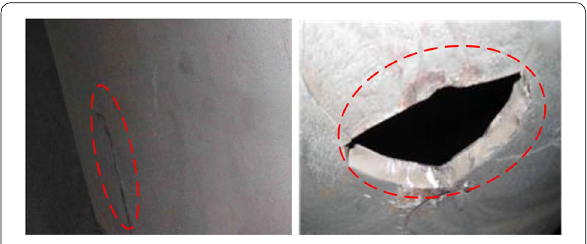
Figure 9 The common crack of pressure